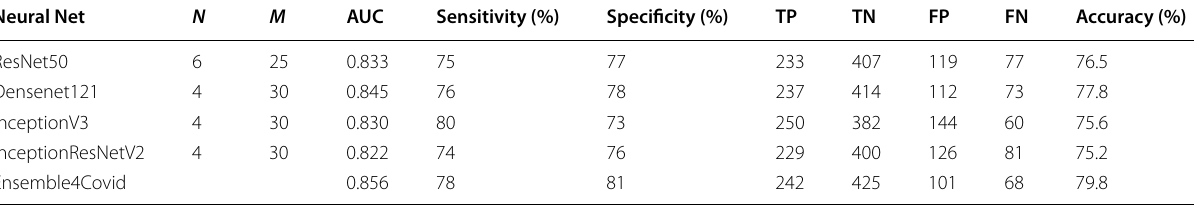
The threshold over the scores used to obtain the sensitivity, specificity, true positives (TP), true negatives (TN), false positives (FP), and false negatives (FN) shown in the table is the one that maximizes the Youden